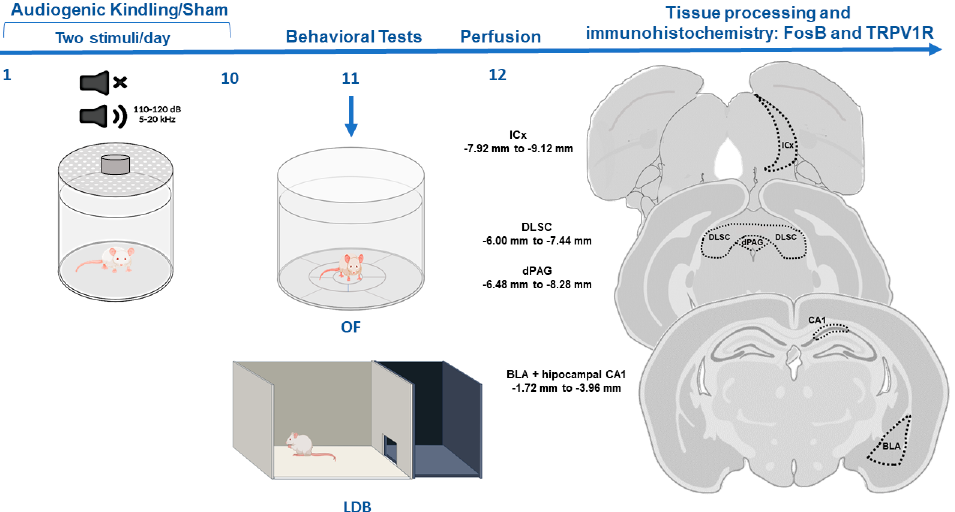
Figure 1. Experimental design. Animals were submitted to the audiogenic kindling (AK) protocol with 20 acoustic simulations. After that, animals were submitted to behavioral tests, and tissue was collected for immunohistochemistry. Abbreviations: OF—open field test, LDB—light/dark box test, ICx—inferior colliculus cortical area, dPAG—dorsal periaqueductal gray matter, DLSC—deep layers of superior colliculus, BLA—basolateral amygdala nucleus, CA1—dorsal hippocampus